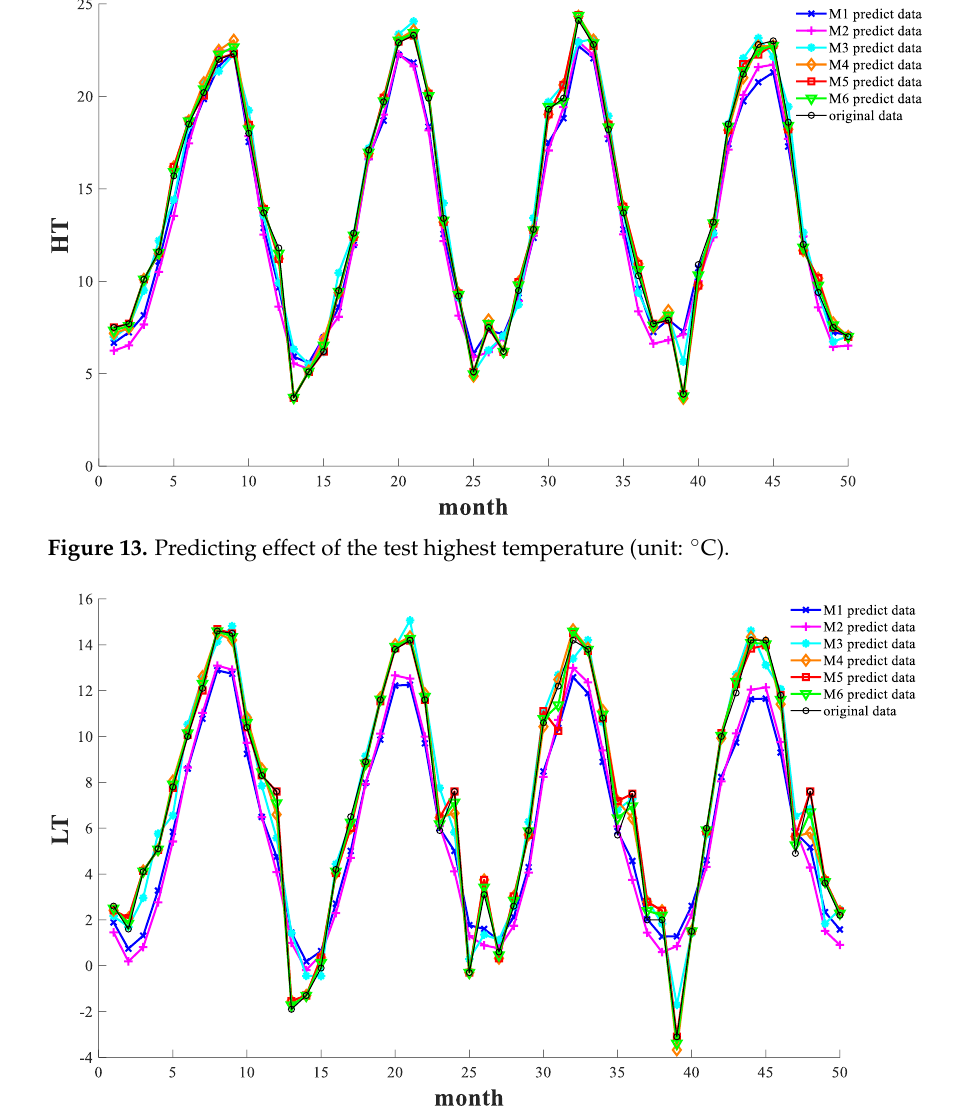
Figure 14. Predicting effect of the test lowest temperature (unit: °C).